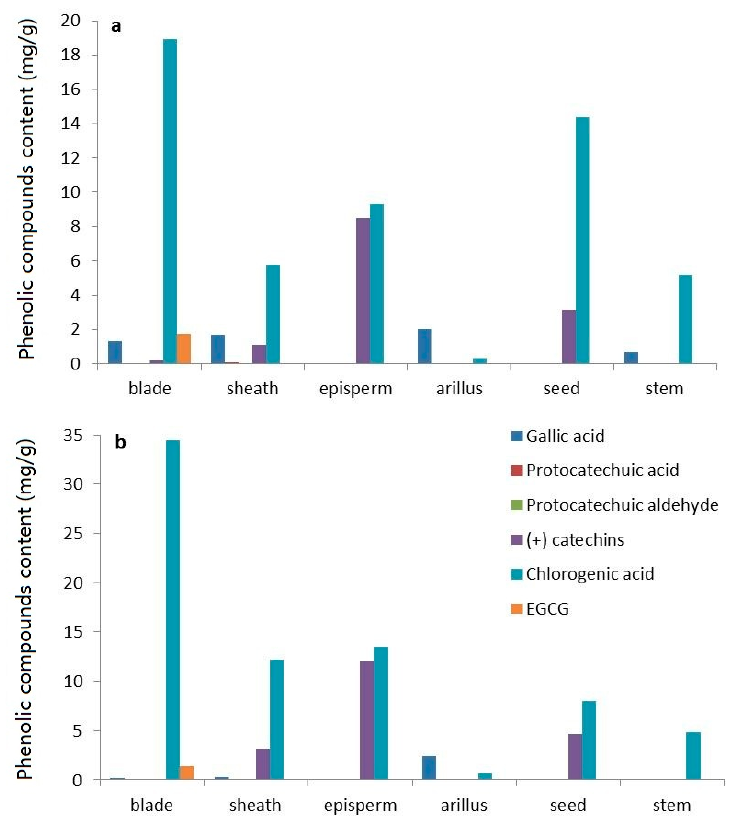
Figure 9. Contents of six phenolic compounds in aqueous extracts ( a ) and DES extracts ( b ) from different parts of rattan plant.